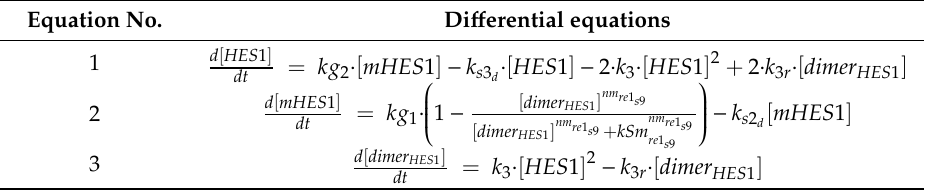
Table A2. Di ff erential equations of the HES1 self-loop